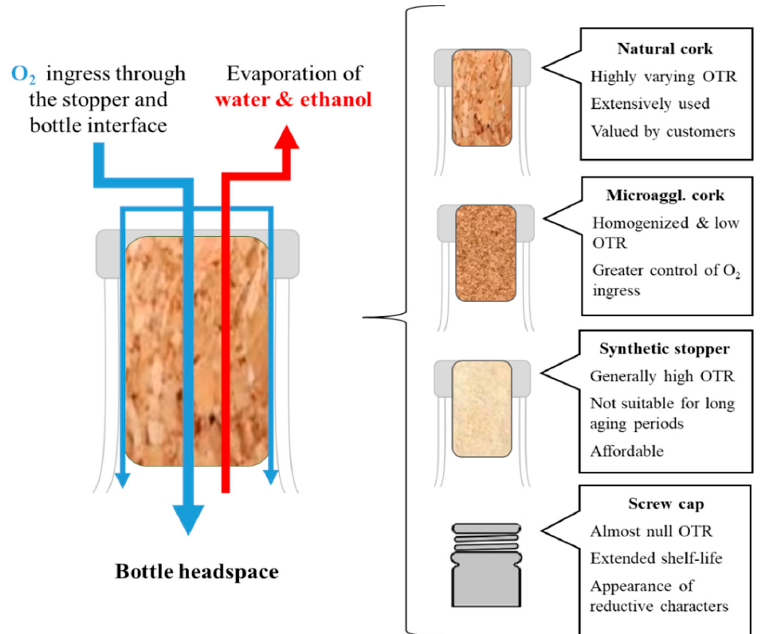
Figure 1. Ingress of oxygen to the bottle through the stopper and characteristics of